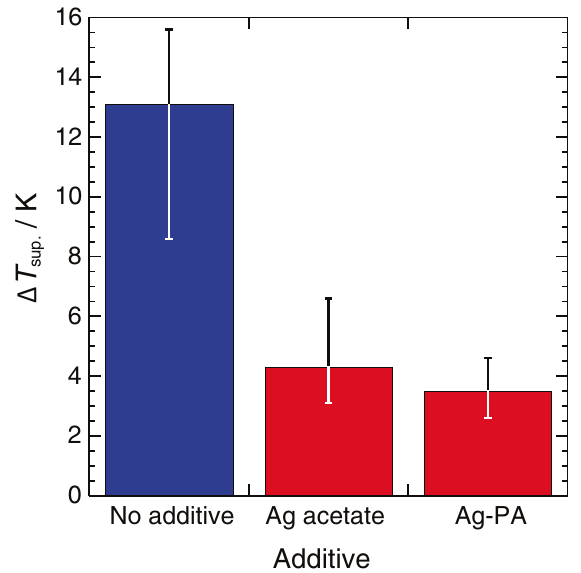
Fig. 5 Effect of Ag carboxylates on the degree of supercooling in the TBAF semiclathrate hydrate (SCH) formation. The equilibrium temperature of TBAF SCH is 300.55-300.75 K 11,44 . Error bars represent standard